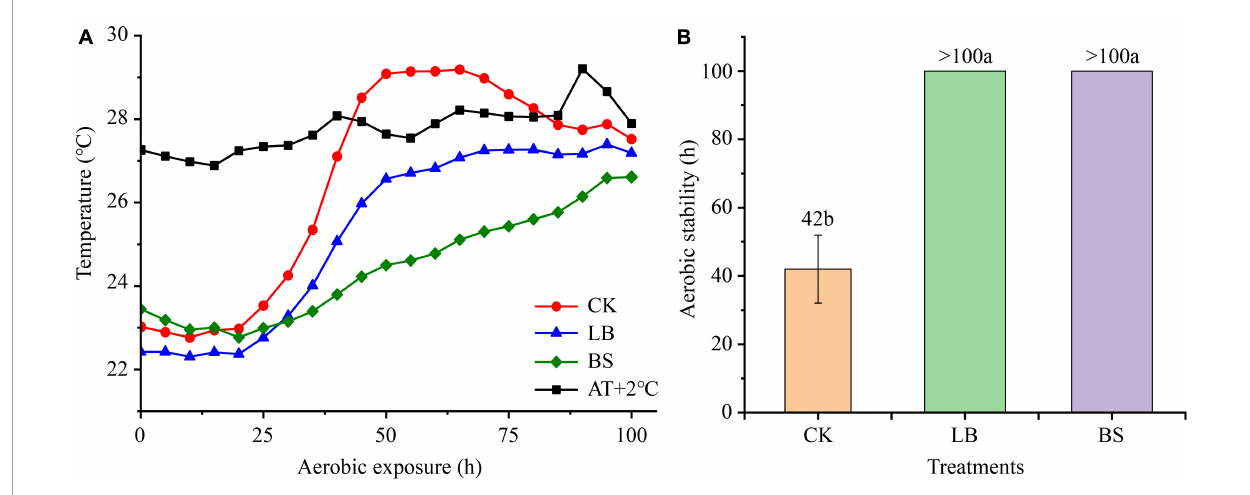
FIGURE1 Dynamics of whole plant corn silage temperature ( ◦ C) versus ambient temperature during aerobic exposure (A) and the time when silage temperature was 2 ◦ C below ambient temperature (B) . Means with different lowercase letters (a–b) indicate significant differences in aerobic stability time ( P < 0.05). AT + 2 ◦ C, ambient temperature +2 ◦ C. CK, control, no inoculations; LB, silages inoculated with Lentilactobacillus buchneri ; BS, silages inoculated with Bacillus subtilis .